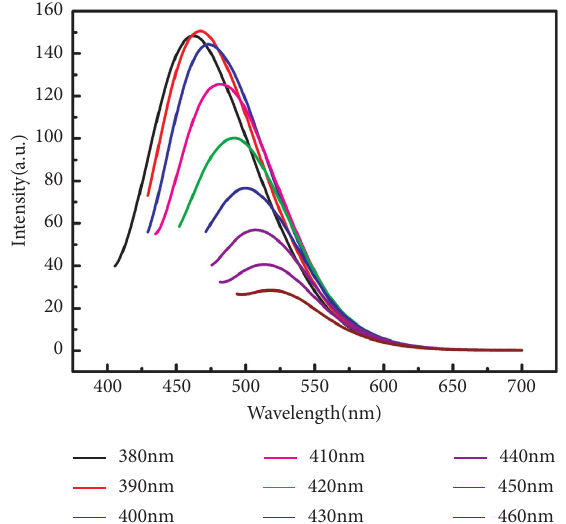
Figure 6: FL spectra of CQDs at different excitation wavelengths.